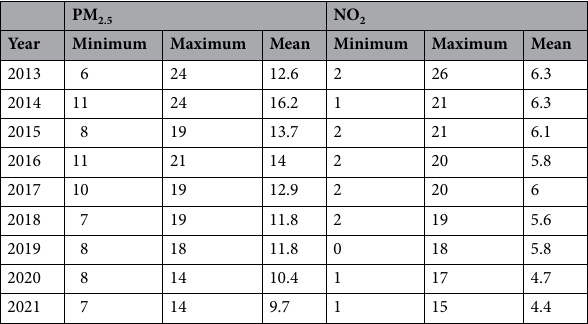
The RF model feature selection results at Tsushima, Goto, Daitou, Inasa, Obama, and Yoshii for PM 2.5 and NO 2 are shown in (Fig. 5). These stations were selected based on their location, which are representative of the study area. Among the monitoring stations, the most important predicting factors for PM 2.5 were Spring, maximin instantaneous wind speed one day, maximum instantaneous wind speed, humidity, sunlight time one day, and southern oscillation index. At the observation tower of Tsushima, Goto, Inasa, and Yoshii, Spring is among the three major predicting factors of PM 2.5, with Spring being the primary predictor at Goto. Maximum instantane-